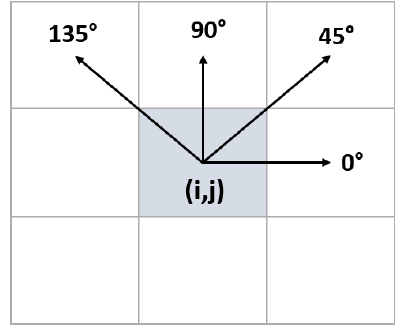
Figure 10. Direction information for neighbor pixel analysis.